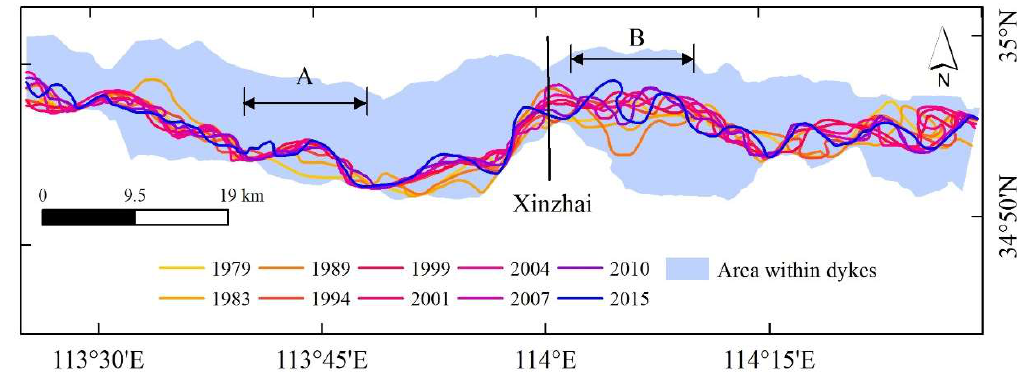
Figure 11. Variation of the main flow pathways from 1979 to 2015.